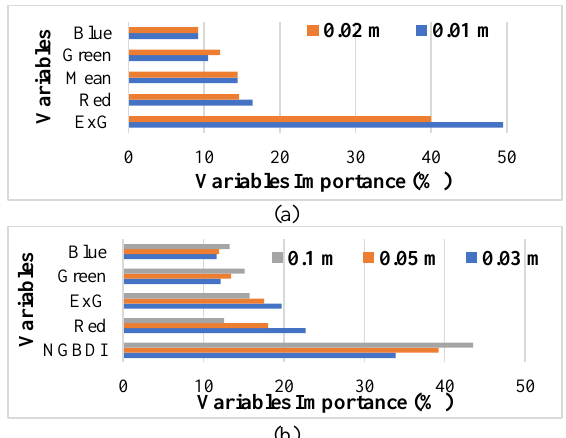
Figure 9 . Input Variables Weight Comparison at image resolution of (a) 0.01m & 0.02m (b) 0.03m, 0.05m & 0.1m